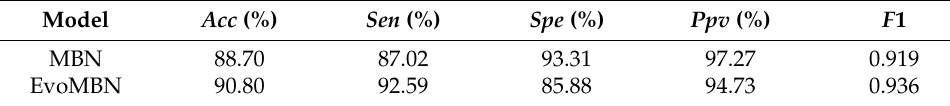
Figure 16. The confusion matrix of MI localization on the PTB-XL database. ( a ) MBN ( b ) EvoMBN. Table 5. The MI detection results on the PTB-XL